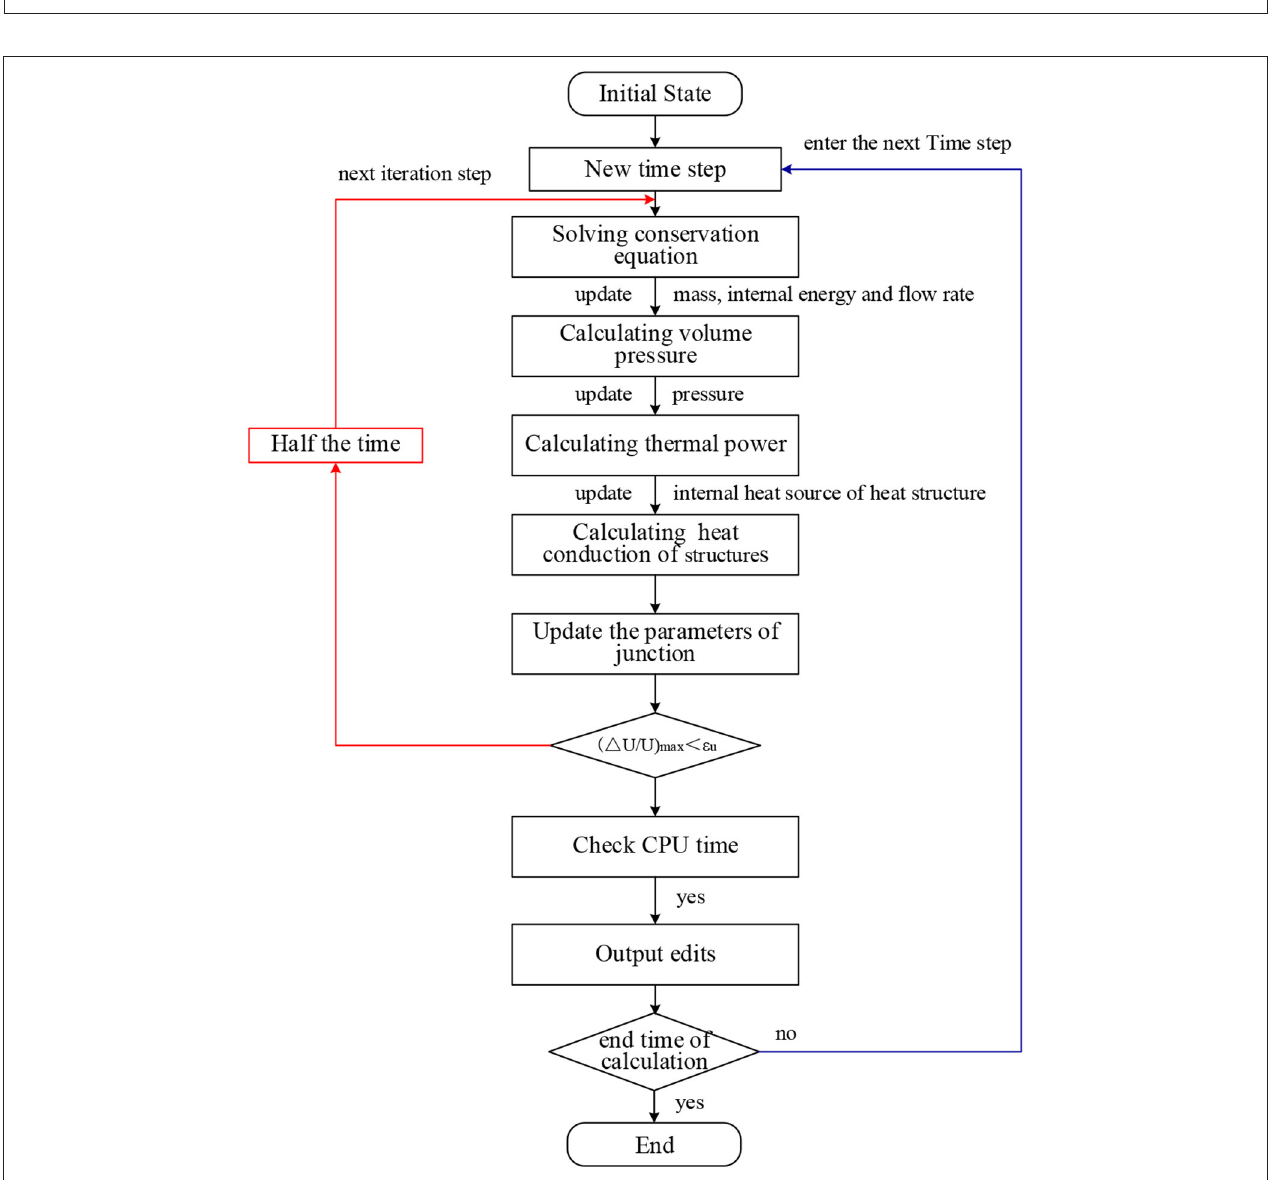
FIGURE 2 | Calculation flow chart of